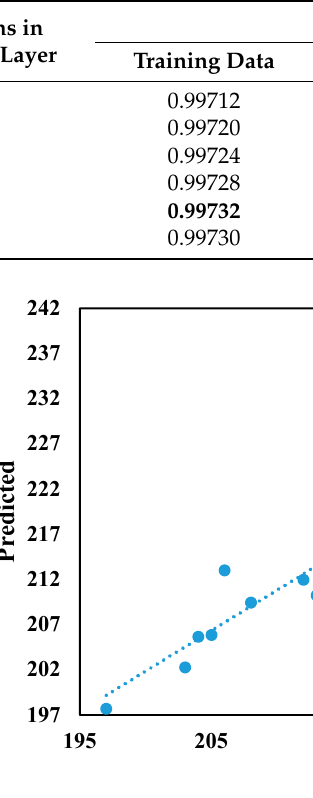
Table 8. Modelling coefficients for predicting the UTS.